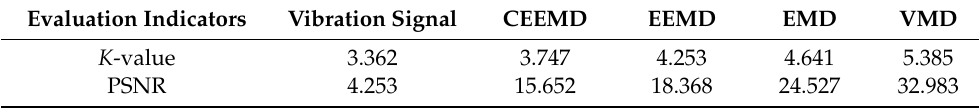
Table 5. The contrastive analysis of the noise reduction with different modal